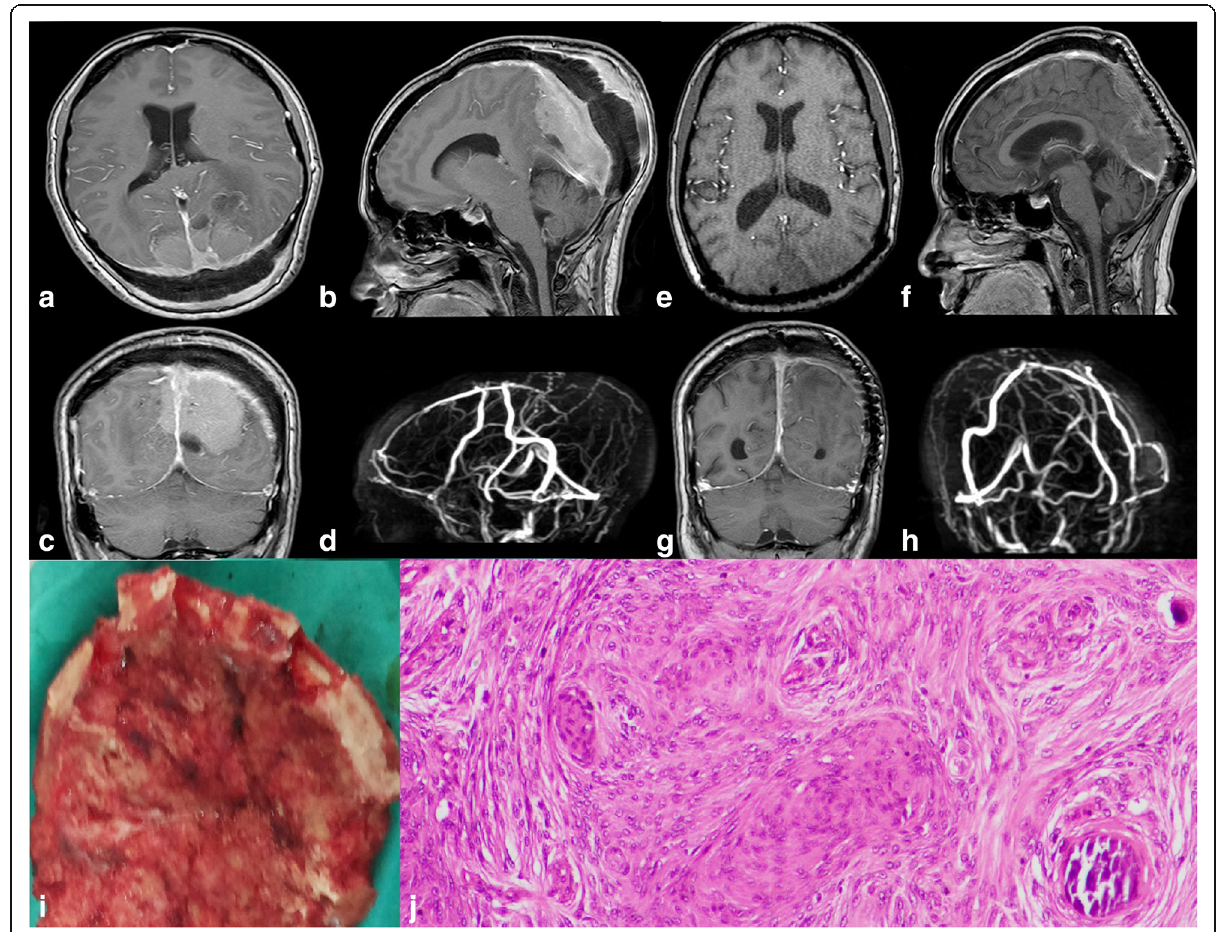
Fig. 1 Meningioma in plaque situated in the parasagittal region. Preoperative image, MRI with contrast. a Axial view verified an enhanced occipital mass. b Sagittal view showed that tumor attached to the bone and involved the sagittal sinus. c Coronal view demonstrated mass lesion was crossing the midline bilateral in the parieto-occipital region more on the left side. The tumor was surrounded by mild edema. d It implicated the posterior aspect of the superior sagittal sinus and left transverse sinus in venography. Two year ’ s postoperative MRI with contrast. e Axial view revealed complete removal with nearly no mass lesion and decompressed occipital horn. f Sagittal view showed small residual mass parafalcine encasing superior sagittal sinus; the bony defect was closed by titanium mesh. g In coronal view, we discovered no mass lesion in the parieto-occipital region. h The posterior aspect of the superior sagittal sinus was opened. Geriatric Scoring System (GSS) score=18. i It showed gross bony invasion of the tumor. j Slide represented